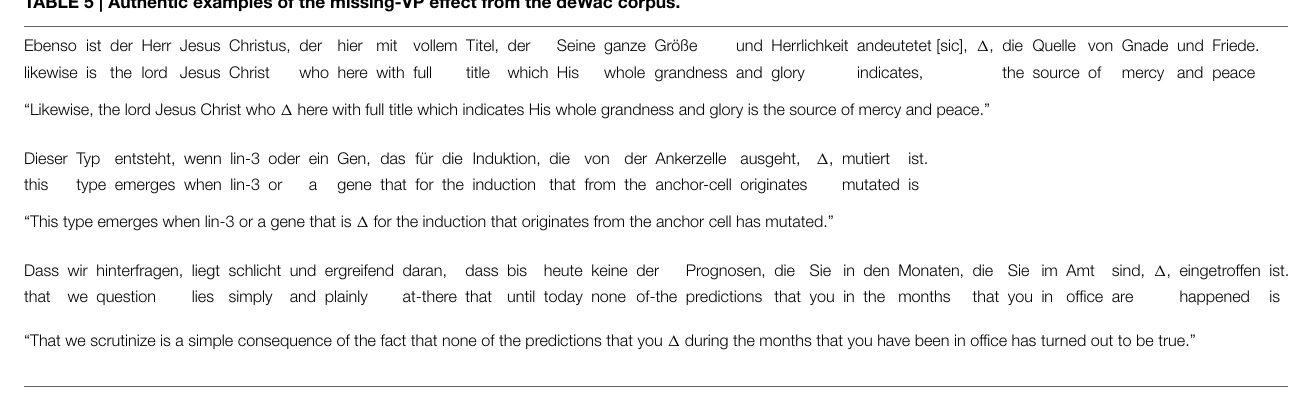
TABLE 5 | Authentic examples of the missing-VP effect from the deWac